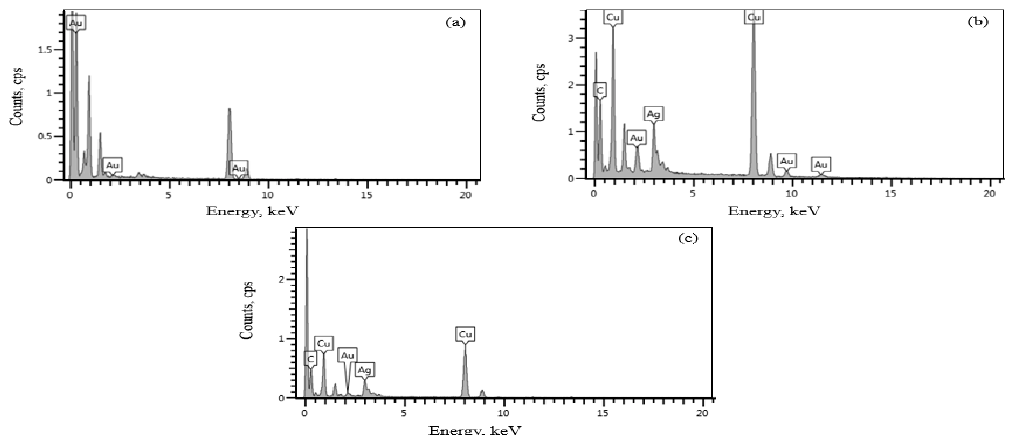
Figure 3. EDS spectraof ( a ) Au NPs, and Au ‐ Ag bimetallic NPs at different volume of ( b ) 2.0 mL and ( c ) 5.0 mL Au seeds.